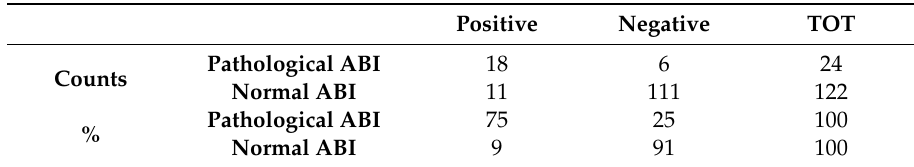
Table 2. Confusion matrix obtained for a specific threshold of PPG-ABI in predicting pathological VE-ABI.